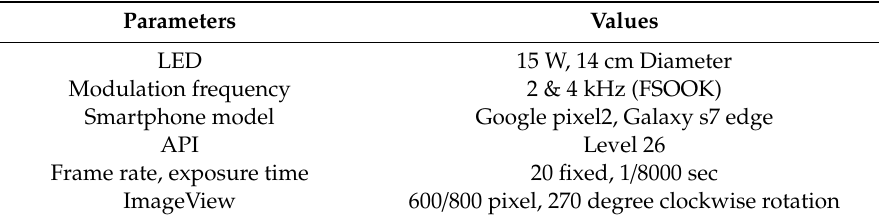
Table 3. Experimental